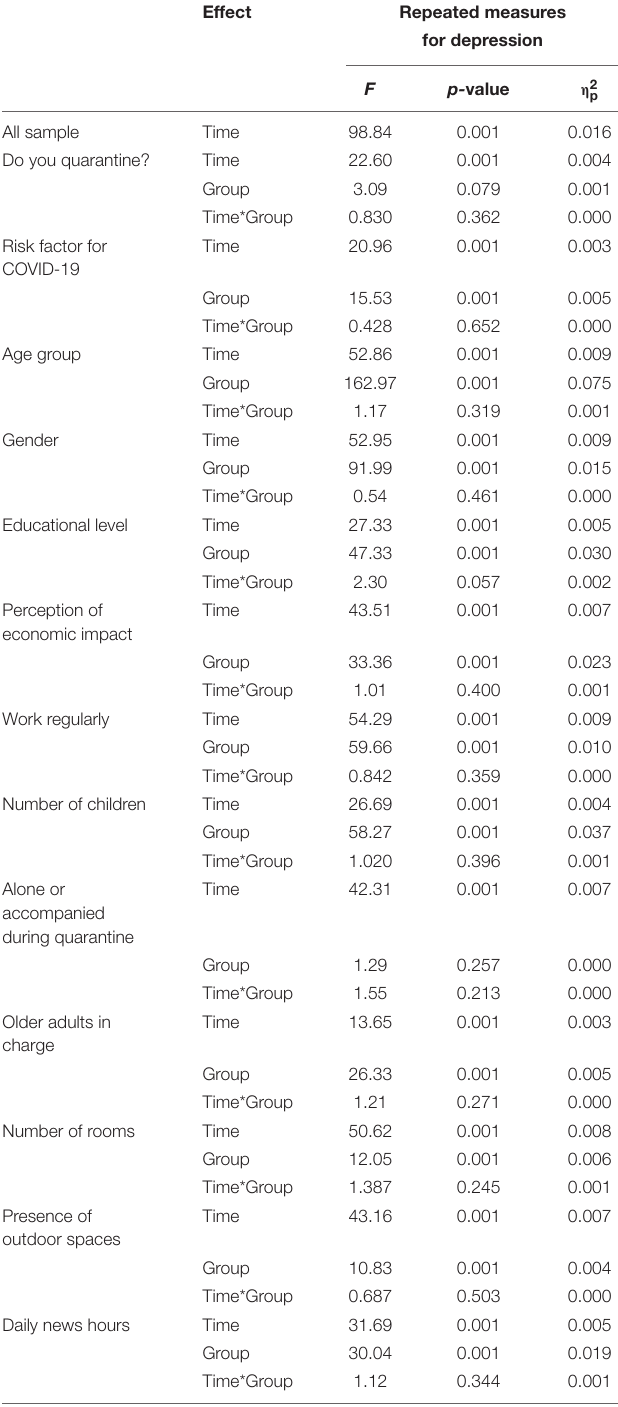
TABLE 3 | Results of repeated measures ANOVA for depression. Effect Repeated